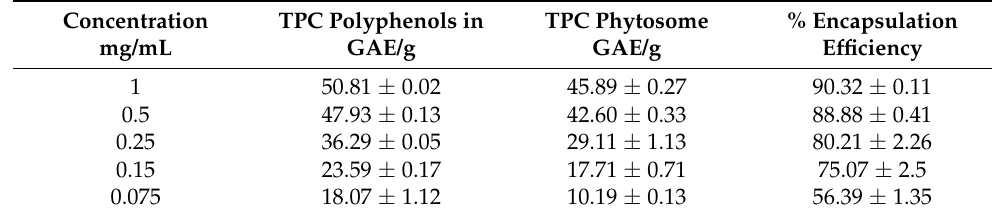
Table 1. Total phenolic content and the encapsulated efficiency.